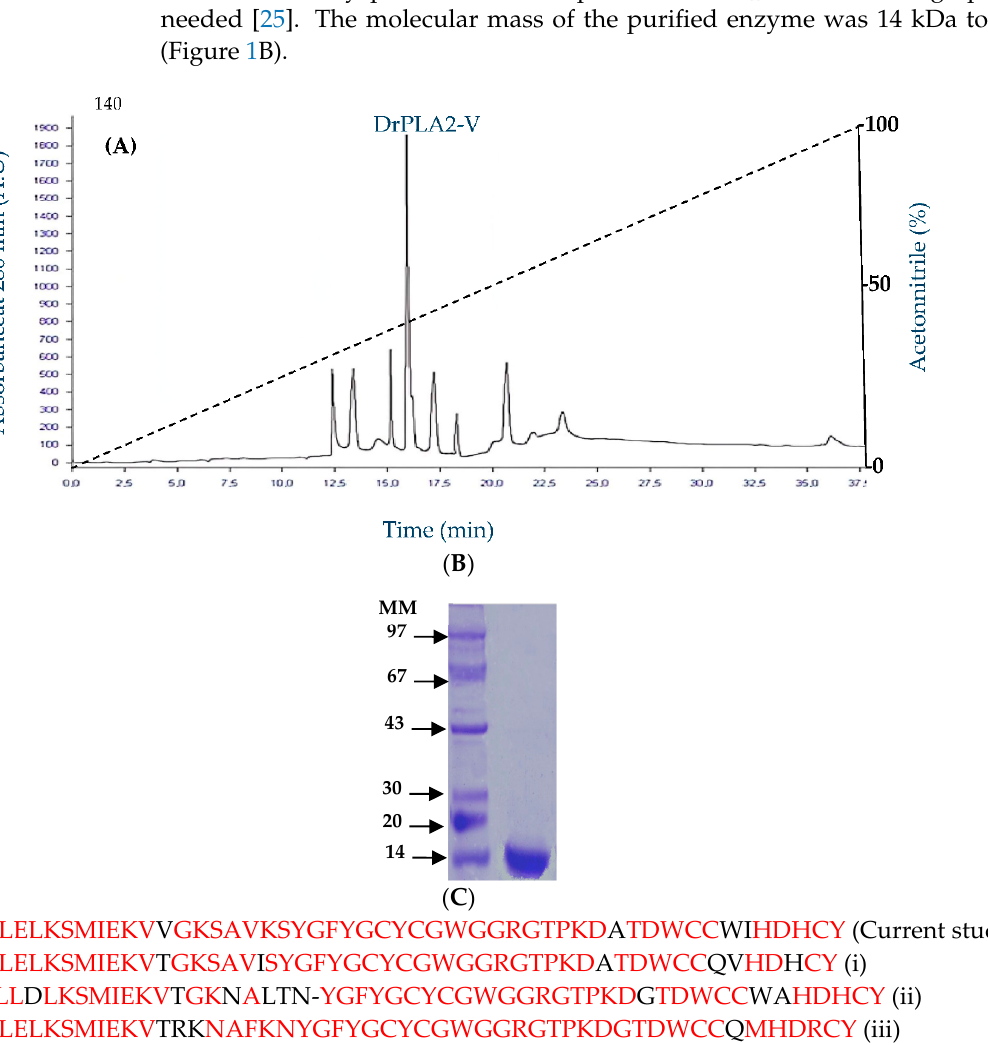
Table 1. Flow sheet of DrPLA 2 -V purification.